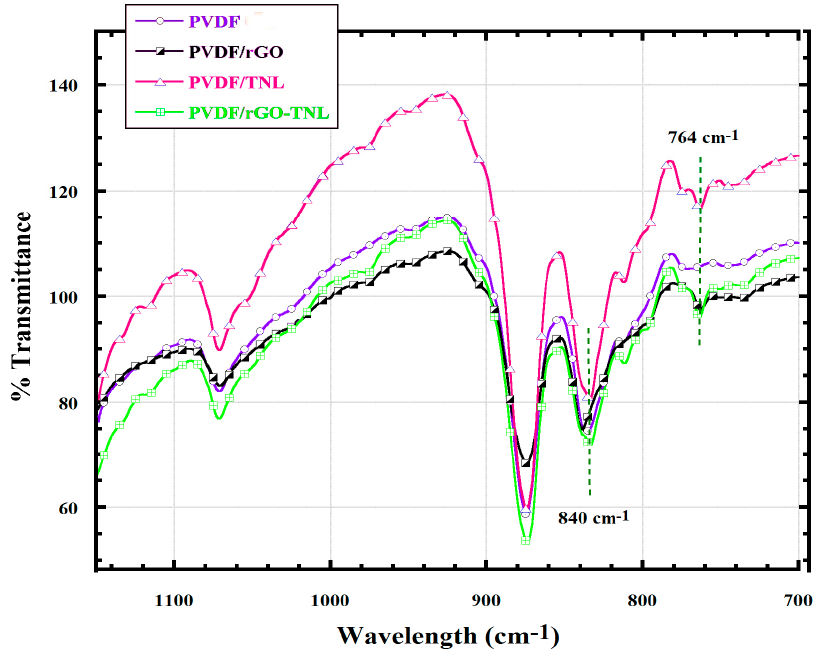
Figure 8. FTIR spectra of neat PVDF and its PVDF/rGO, PVDF/TNL, and PVDF/rGO-TNL composite samples.